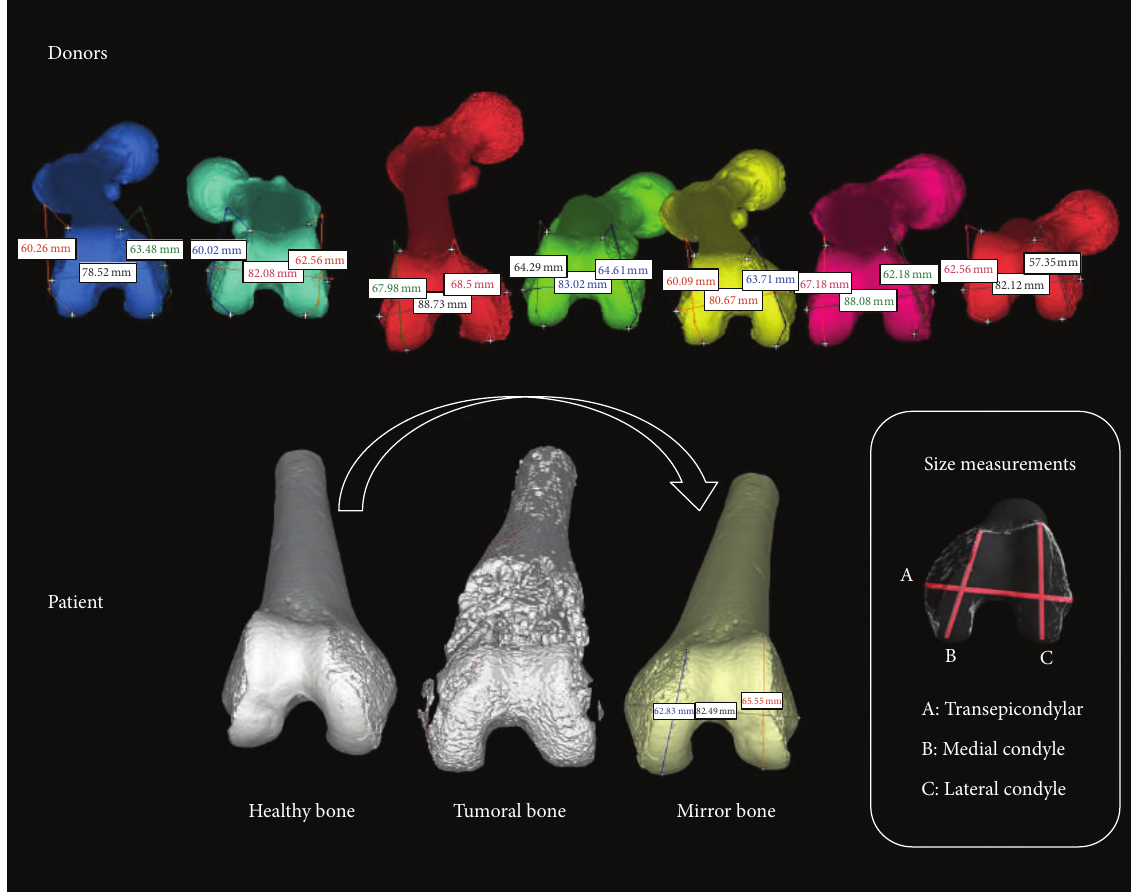
Figure 2: Donors were measured using ABC measurements. The healthy bone of the patient was mirrored and then measured with ABC measures in order to compare the best match according to the